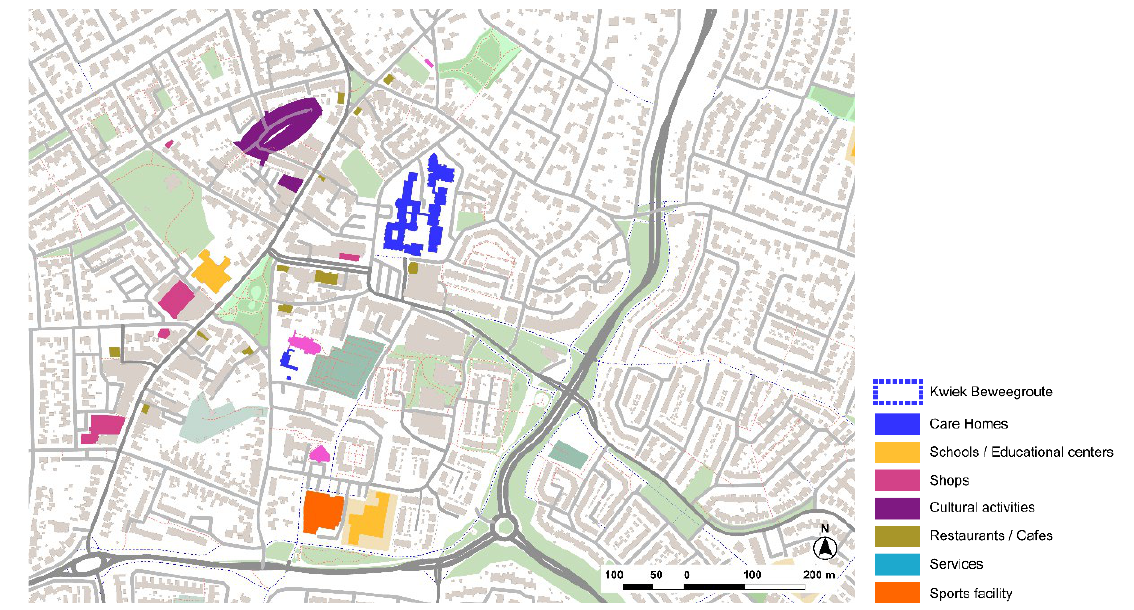
Figure 24. Analysis of the immediate surroundings in which the Kwiek Beweegroute project is set in Nuenen. Source: Own elaboration.